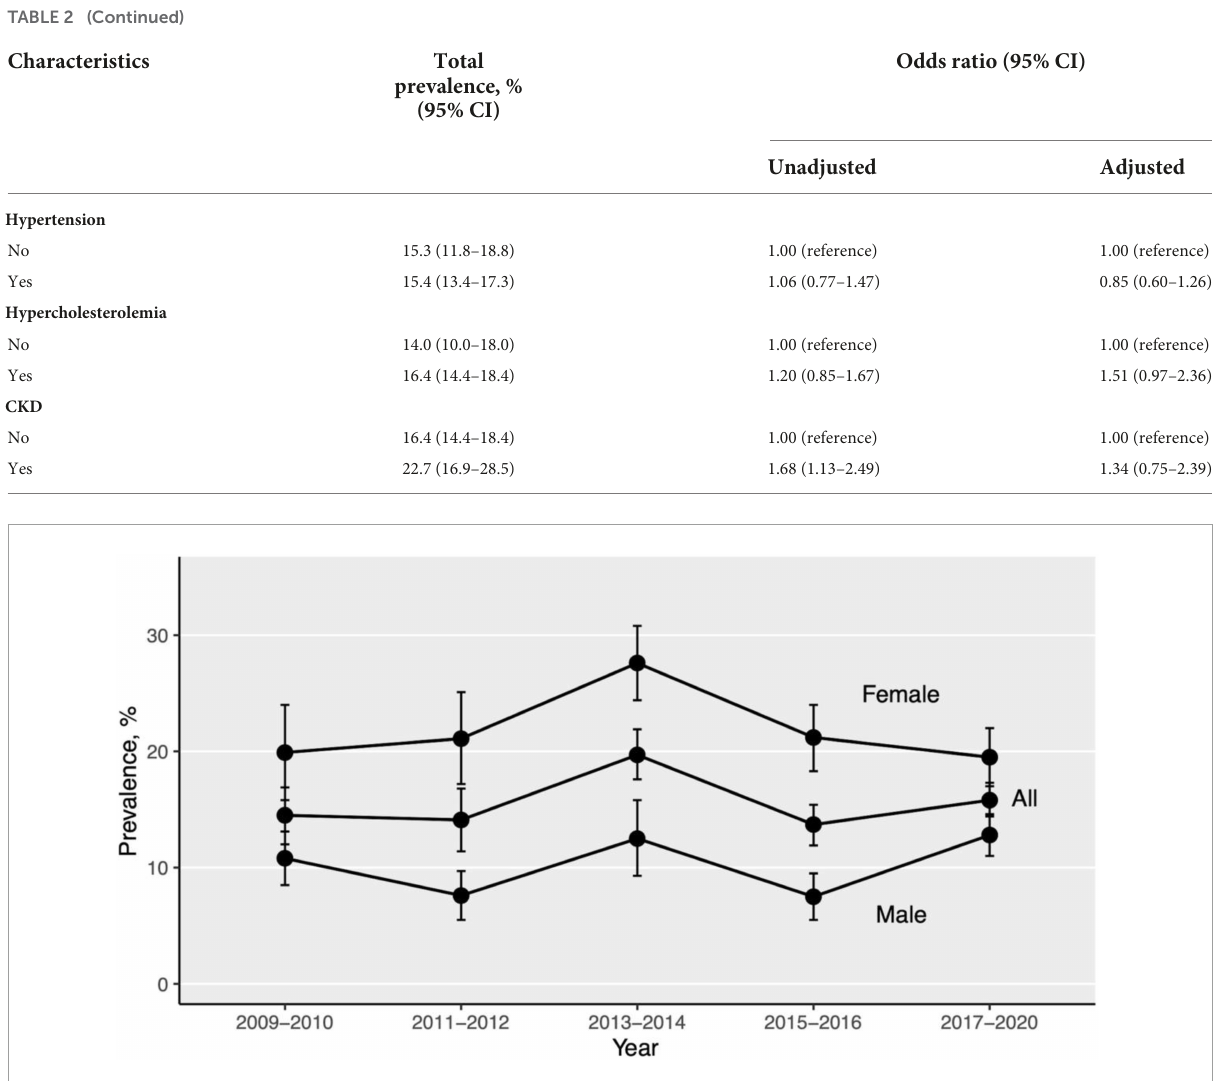
FIGURE2 Trends in prevalence of depression by gender, 2009–March 2020. Error bars indicate standard errors. Specific estimates are shown in Table 3